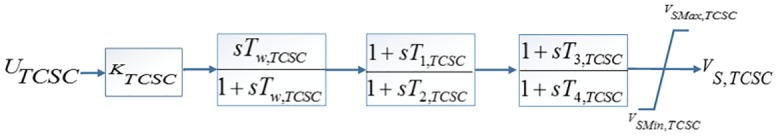
Block diagram of the TCSC POD controller.